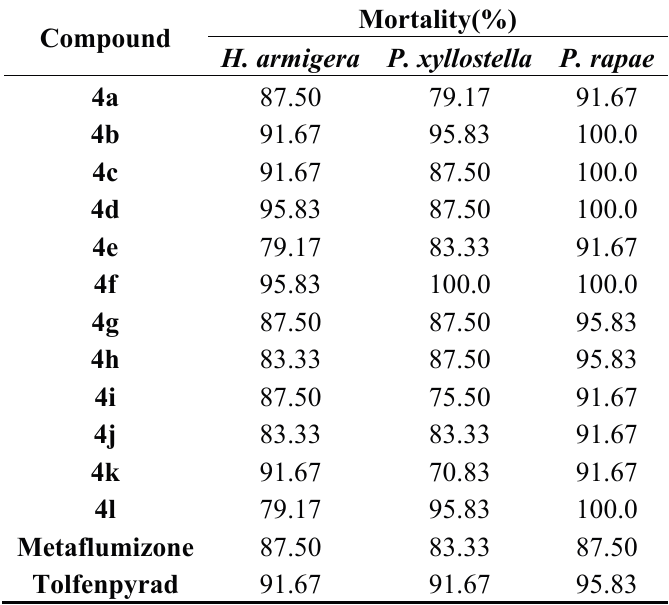
Table 2. Insecticidal activities of acylhydrazone derivatives (concentration, 10 mg/L; treatment time, 72